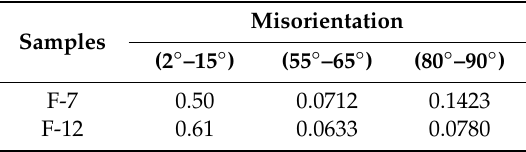
Figure 6. Misorientation distributions of various samples: ( a , c , e ) F-7; ( b , d , f ) F-12. Table 1. The distributions of grain boundary angle of various samples.